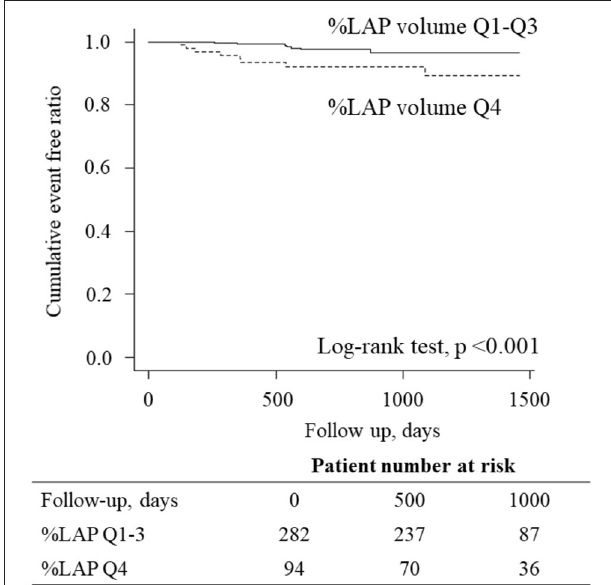
FIGURE 3 | Kaplan-Meier curves analysis according to the LAP burden. Kaplan-Meier curve analysis illustrated that patients having %LAP (Q4) had a worse prognosis than those with Q1–Q3 ( p < 0.001, log-rank test).